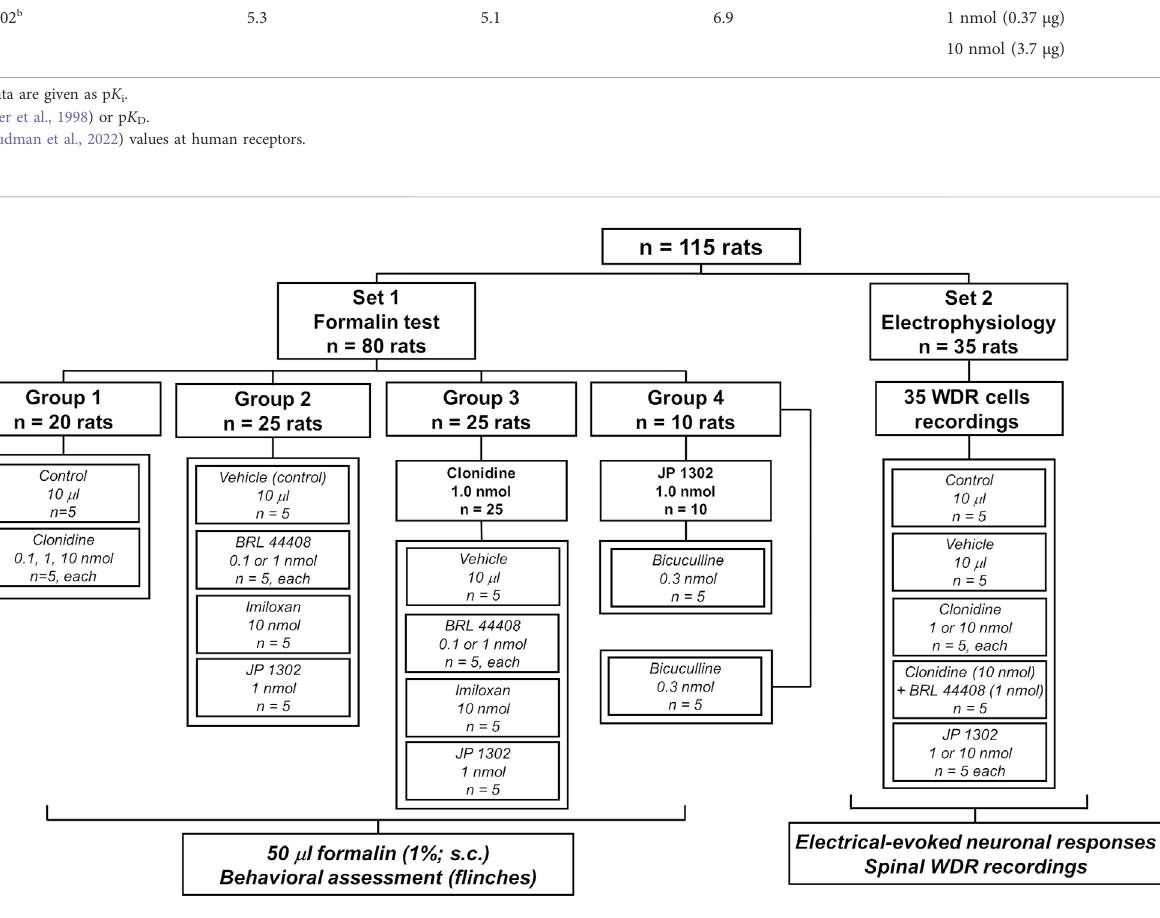
FIGURE 1 Experimental protocols showing the number of animals used in the present study. The animals were divided into two main sets to perform behavioral or in vivo electrophysiological